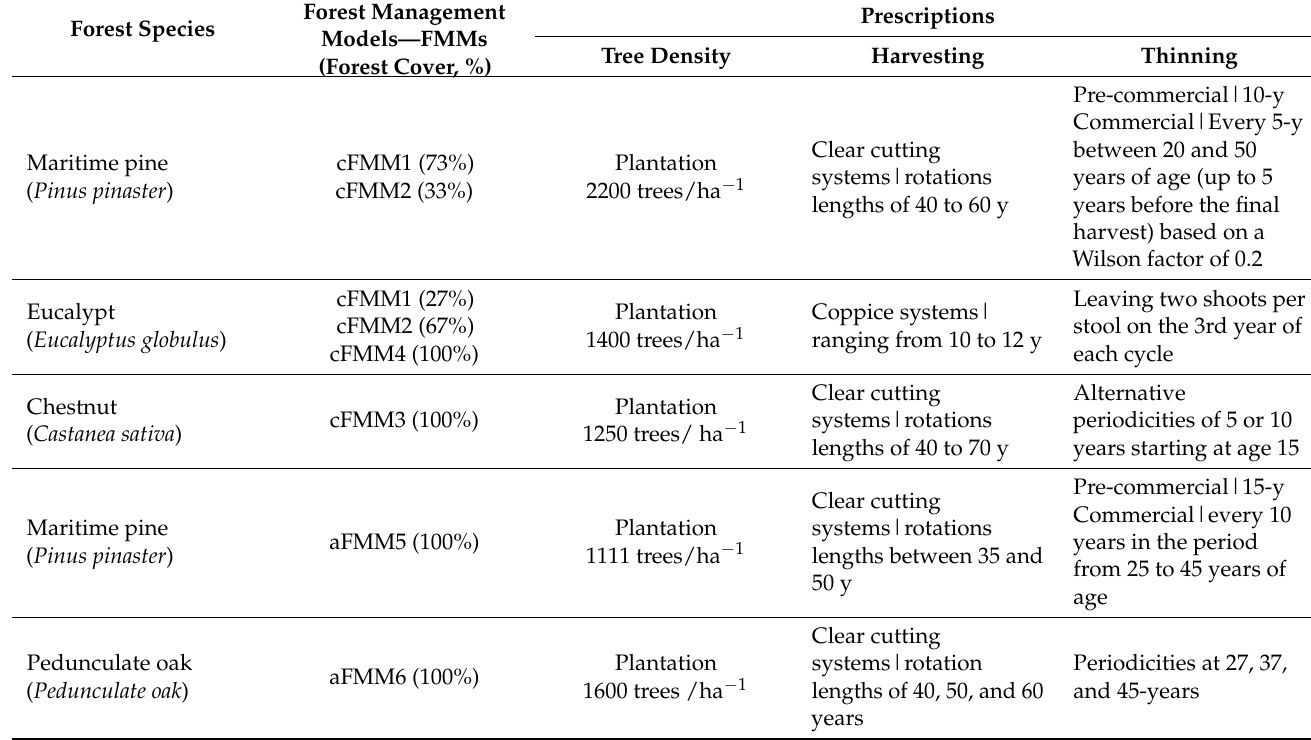
Figure 1. Vale de Sousa Case study area (Vsousa_CSA) location in Portugal, with 1373 management units (MU) and Current stand-level forest management models (cFMMs). Table 1. Forest species, current and alternative forest management models and corresponding prescriptions at Vale do Sousa case study area.